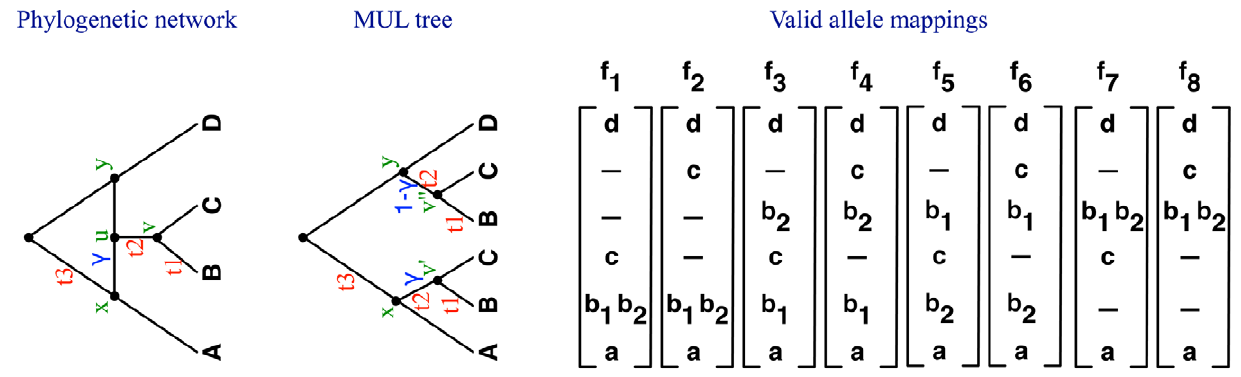
Figure 1. Phylogenetic networks, MUL trees, and valid allele mappings. In this example, single alleles a , c , and d were sampled from each of the three species A , C , and D , respectively, whereas two alleles ( b 1 and b 2 ) were sampled from species B . See text and Text S1 for